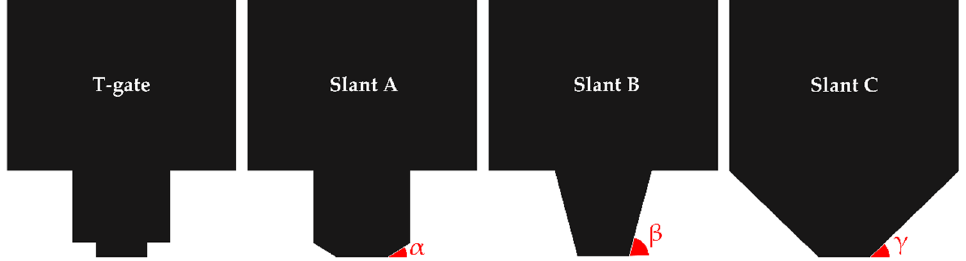
Figure 6. Schematics of various gate electrode structures for the AlGaN/GaN HEMT: A basic T-gate structure, slant A structure, slant B structure, and slant C structure.